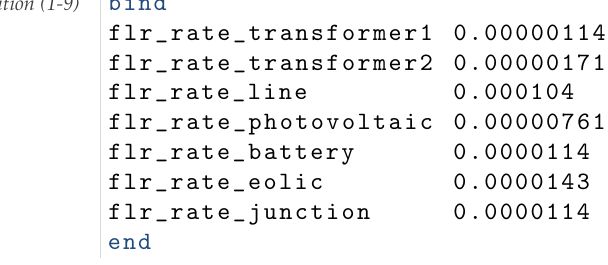
Figure 8. Variables representing the components’ fault rates (SHARPE